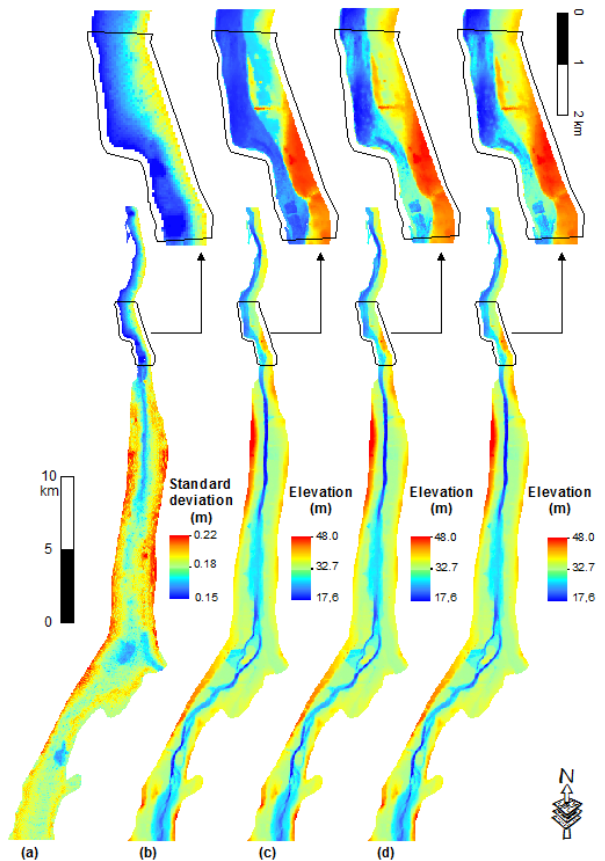
Figure 6. Topography ( a ) standard deviation, and representations of the random topography fields: ( b ) lower topography scenario; ( c ) mean topography scenario; and ( d ) upper topography scenario.